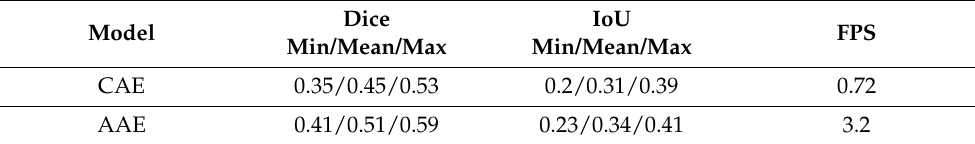
Table 4. The quantitative detection of two networks.